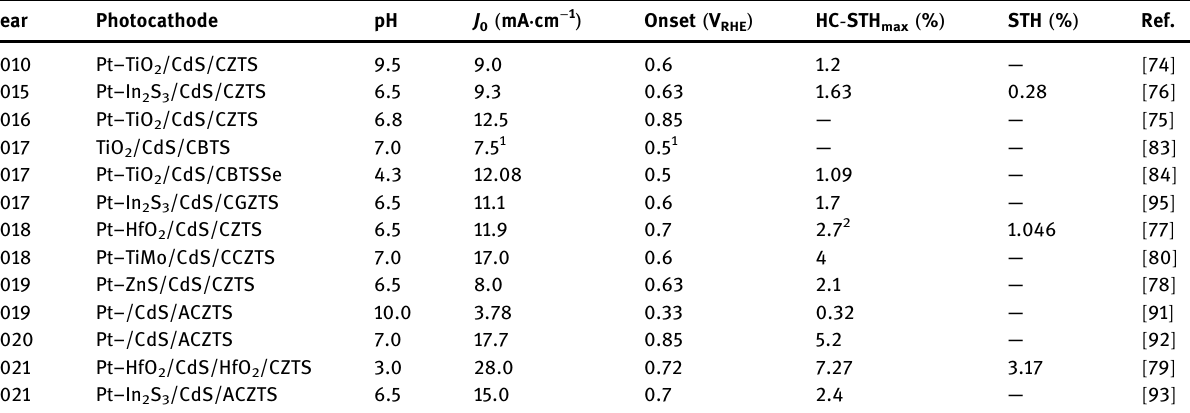
Table 2: Properties of copper kesterite photocathodes for water reduction Photocathode